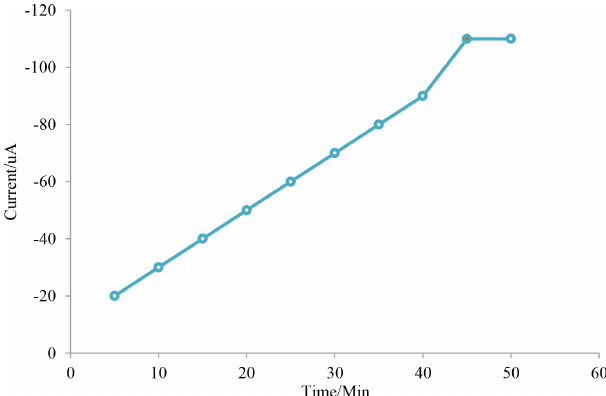
Figure 3. Best hybridization time for the Aeromonas hydrophila DNA biosensor in time range 5–50min; the optimum was 45min.